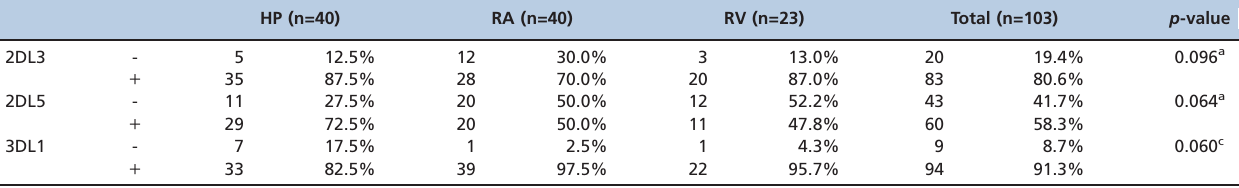
Table 4 - Distribution of KIR genotypes among the patient